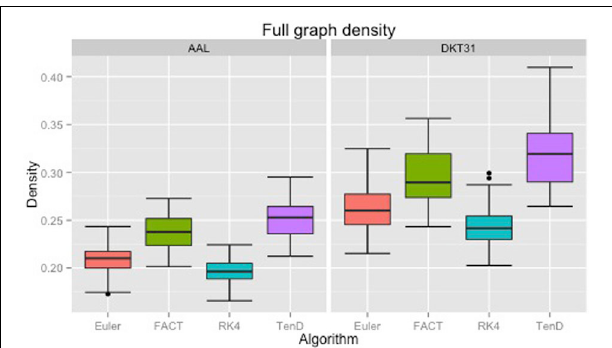
FIGURE 4 | Boxplots illustrating the density values for unthresholded connectivity matrices for all subjects and all time points, grouped by fiber tracking algorithm (Euler, FACT, RK4, TEND) and anatomical label set (AAL, DKT31). Black dots indicate data points whose distance from the hinge is more than 1.5 ∗ inter quantile